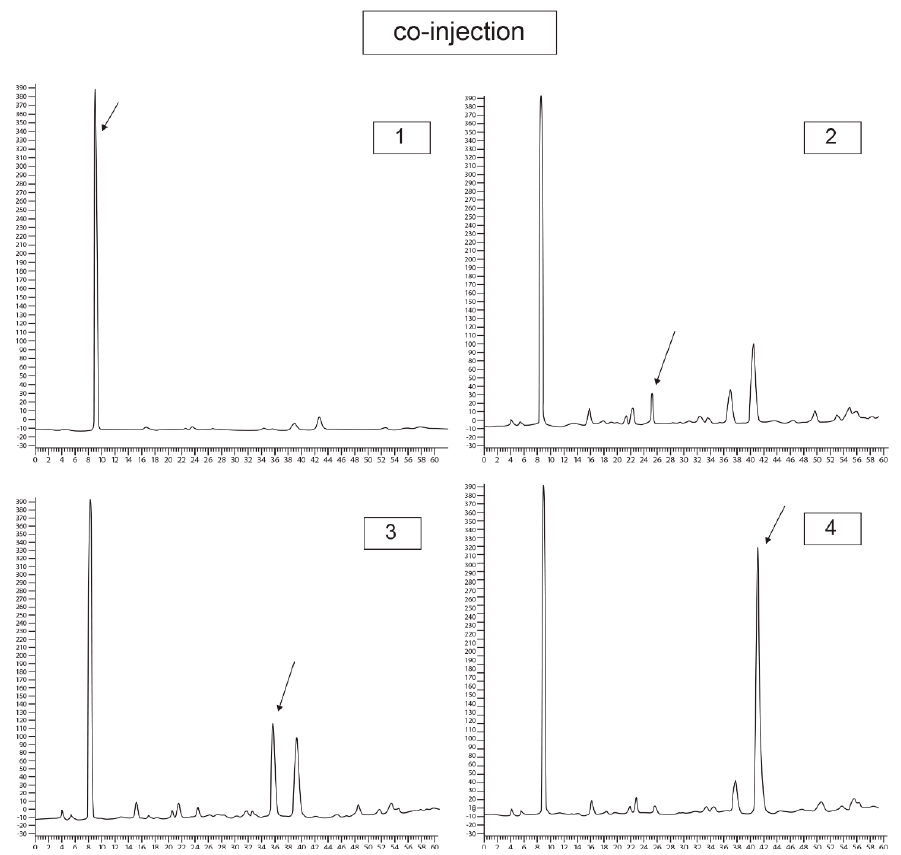
Figure 2. Chromatograms obtained by the coinjection of gallic acid (1); catechin (2); epicatechin (3) and epigallocatechin (4) standards with the EtOAc phase of acetone extract of A. occidentale barks. Table 2. Peak areas of interest on chromatogram for A. occidentale EtOAc fraction with and without coinjection of gallic acid, catechin, epicatechin and epigallocatechin.